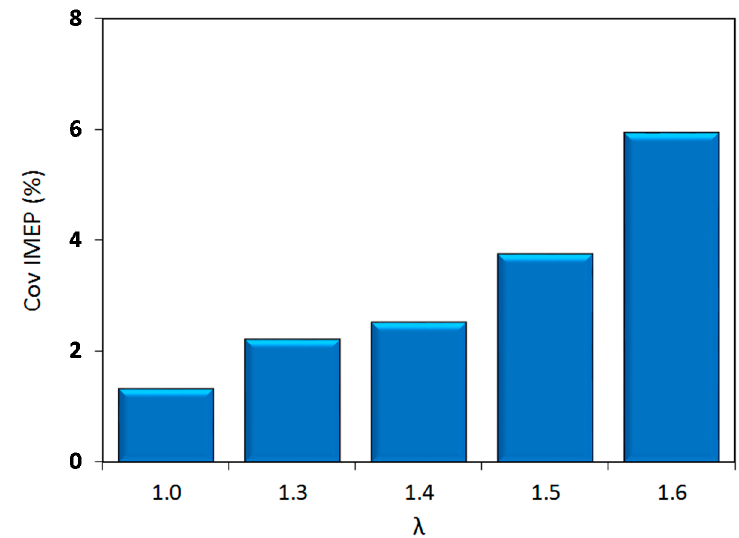
Figure 4. COV IMEP evaluated on 200 consecutive engine cycles for different air fuel ratios.